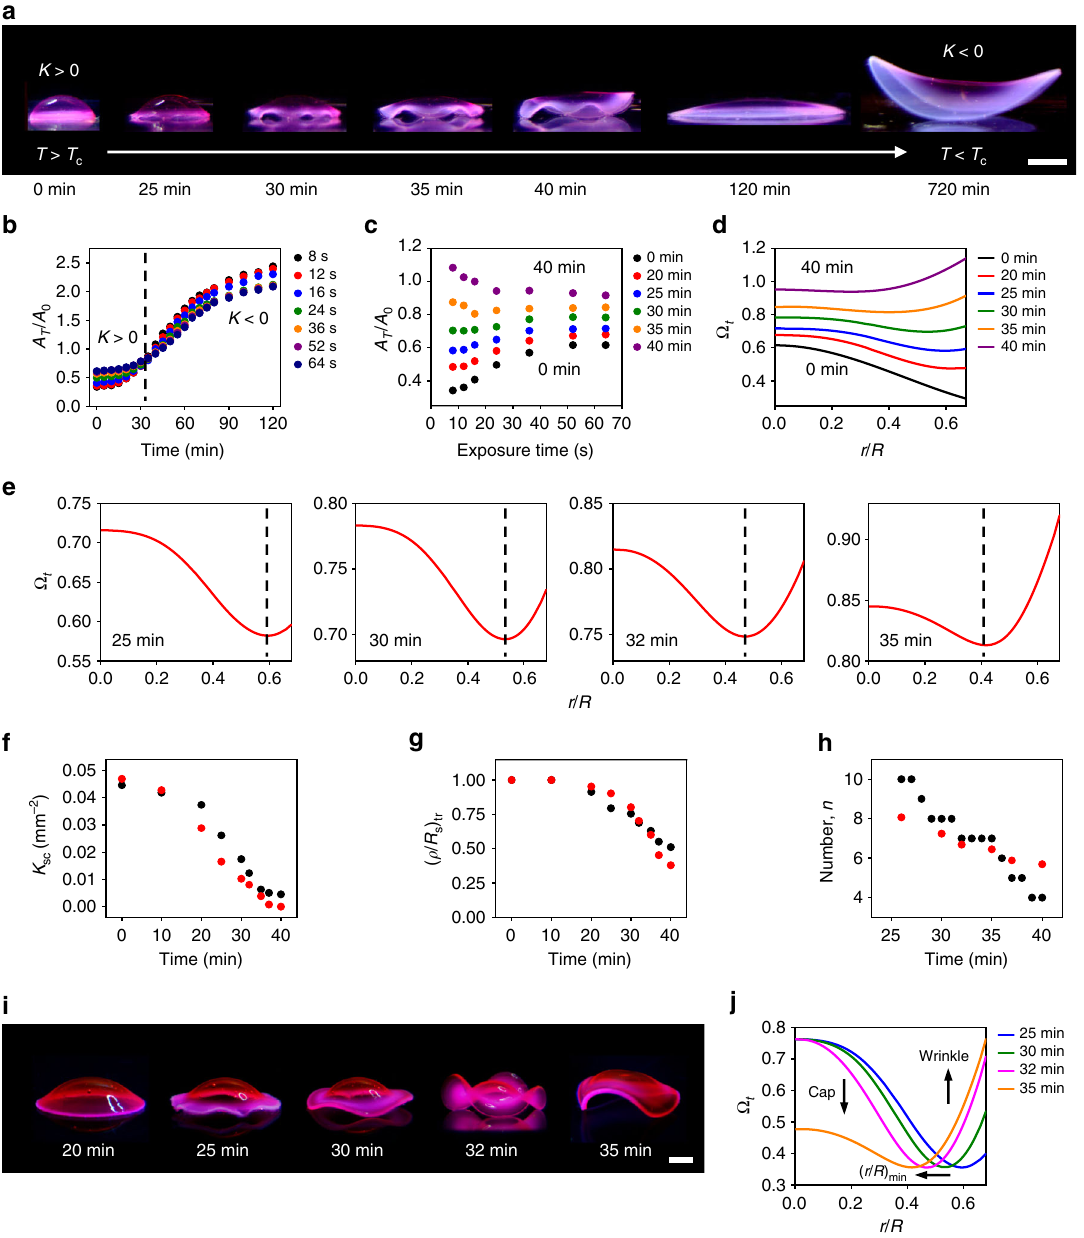
Fig. 5 Dynamic behavior of growth-induced 3D structures. a Shape evolution of a spherical cap during cooling. b A T / A 0 of homogeneous hydrogels formed with different t ex as a function of cooling time t . The black, red, blue, green, orange, purple, and navy circles represent A T / A 0 of the hydrogels formed with t A T / A t t (dynamic calibration curves). The black, red, blue, green, ex of 8, 12, 16, 24, 36, 52 and 64 s, respectively. c 0 in b as a function of ex at different orange, and purple circles represent A T / A 0 at t of 0, 20, 25, 30, 35 and 40 min, respectively. d Dynamic growth function (or target metric) Ω t of the spherical cap at t = 0 to 40 min. The black, red, blue, green, orange, and purple lines represent Ω t at t of 0, 20, 25, 30, 35 and 40 min, respectively. e Ω t for the shapes of the spherical cap in a at 25, 30, 32 and 35 min. f Experimentally measured K sc ( K of the spherical cap-like shape in the center) (black circles) and theoretically calculated K sc (red circles) as a function of t . g Experimentally measured ( ρ / R s ) tr (location of the shape transition) (black circles) and theoretically calculated ( ρ / R s ) tr (red circles) as a function of t . h Experimentally measured number of the wrinkles (black circles) as a function of time. The red circles represent n obtained from the fi t of Ω = c /[1 + ( r /( aR )) 2 ] 2 + [1 + ( r / R ) n ] 2 − 1 to Ω t as described in the main text and Supplementary Figure 20. i Replicated structures of the dynamic shapes of the spherical cap in a at 20, 25, 30, 32 and 35 min. j Normalized Ω t used to create the structures shown in i . The blue, green, magenta, and orange lines represent Ω t at 25, 30, 32 and 35 min, respectively. Scale bars, 5 mm in a ; 2 mm in Ω Supplementary Figures 16, 17). During this transition, Ω t t for the spherical cap (Fig. 5d, e, Supplementary Figure 16) undergoes complex transformations, forming hybrid elliptic and from its static growth function (shown in Fig. 2g), using the hyperbolic metrics (Fig. 5d, e) and thus inducing hybrid 3D dynamic calibration curves (shown in Fig. 5c, Supplementary shapes (Fig. 5a, Supplementary Figure 18). The spatially nonuni- Figure 15). Ω t shows how the metric of the spherical cap changes form kinetics of swelling produces hybrid Ω t with a minimum at with time and thus how the structure changes its shape (Fig. 5d, e,